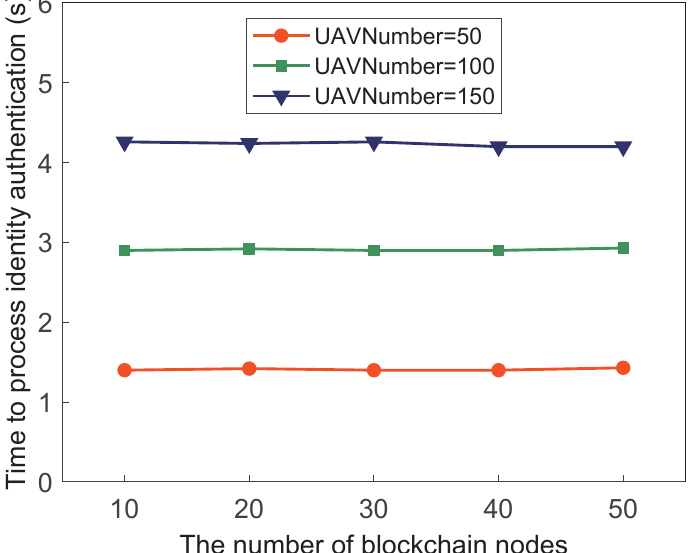
Figure 8. Identity authentication time according to the number of blockchain